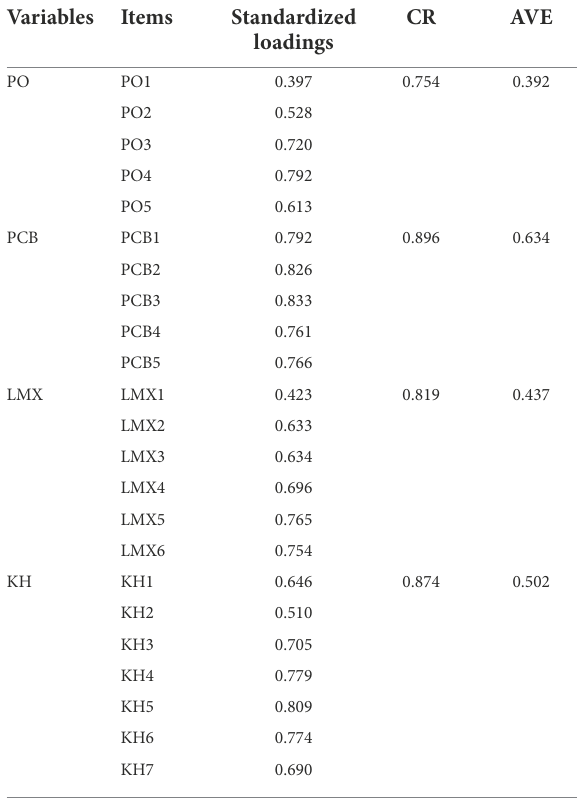
TABLE 3 The standardized loadings, composite reliability (CR) and average extracted variance (AVE). Variables